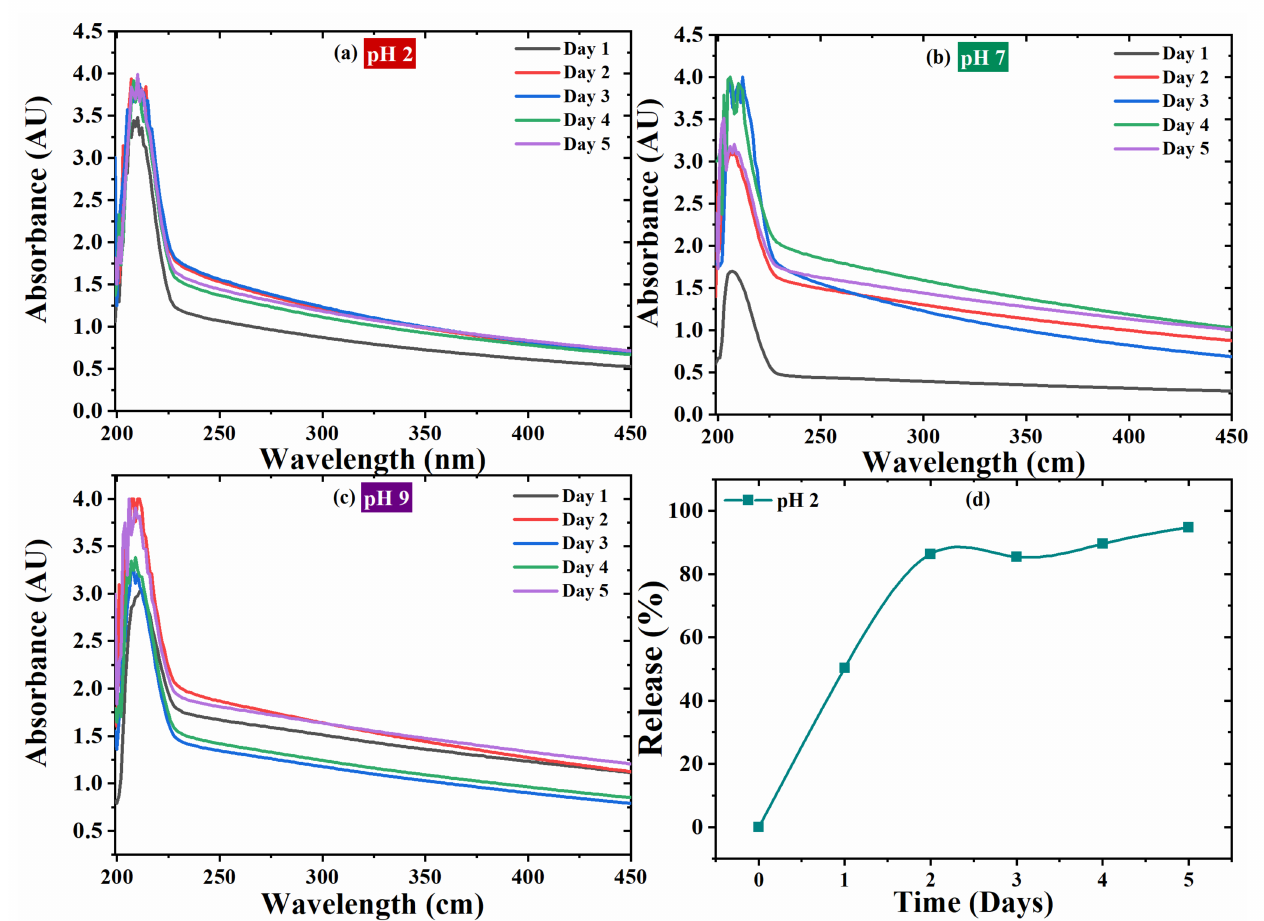
Figure 5. UV-Vis Spectra at ( a ) pH 2, ( b ) 7 and ( c ) 9 for Y 2 O 3 /imidazole, ( d ) release (%)